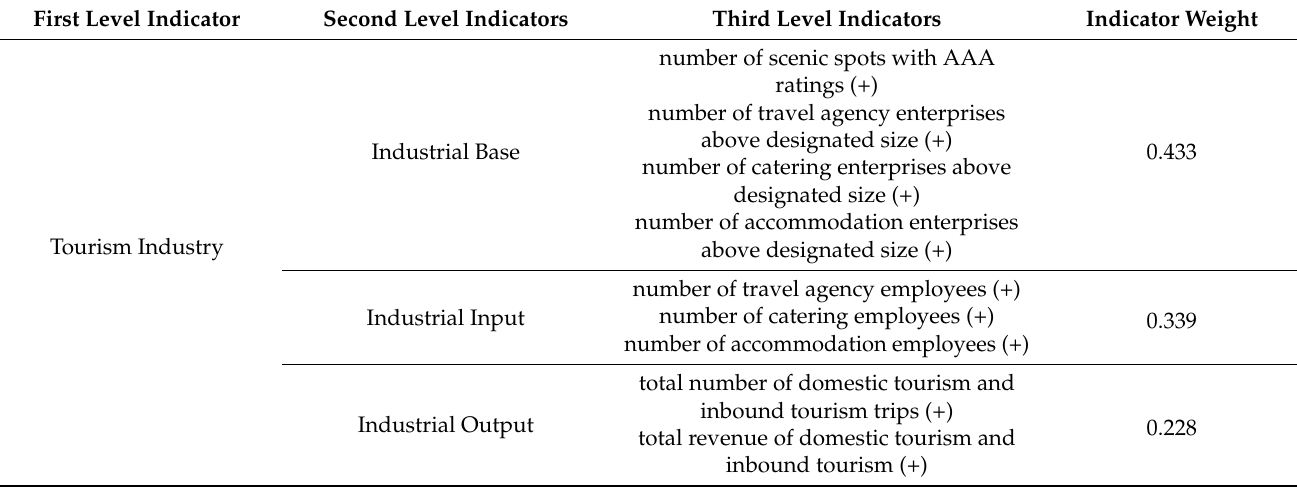
Table 1. Index evaluation system and weight for the tourism